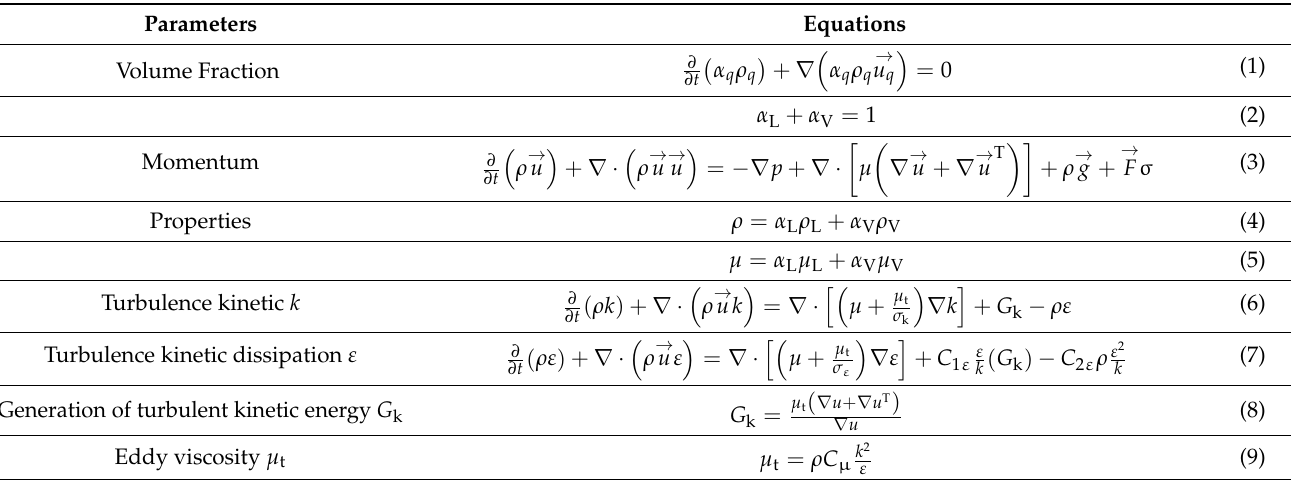
Table 1. Governing equations.